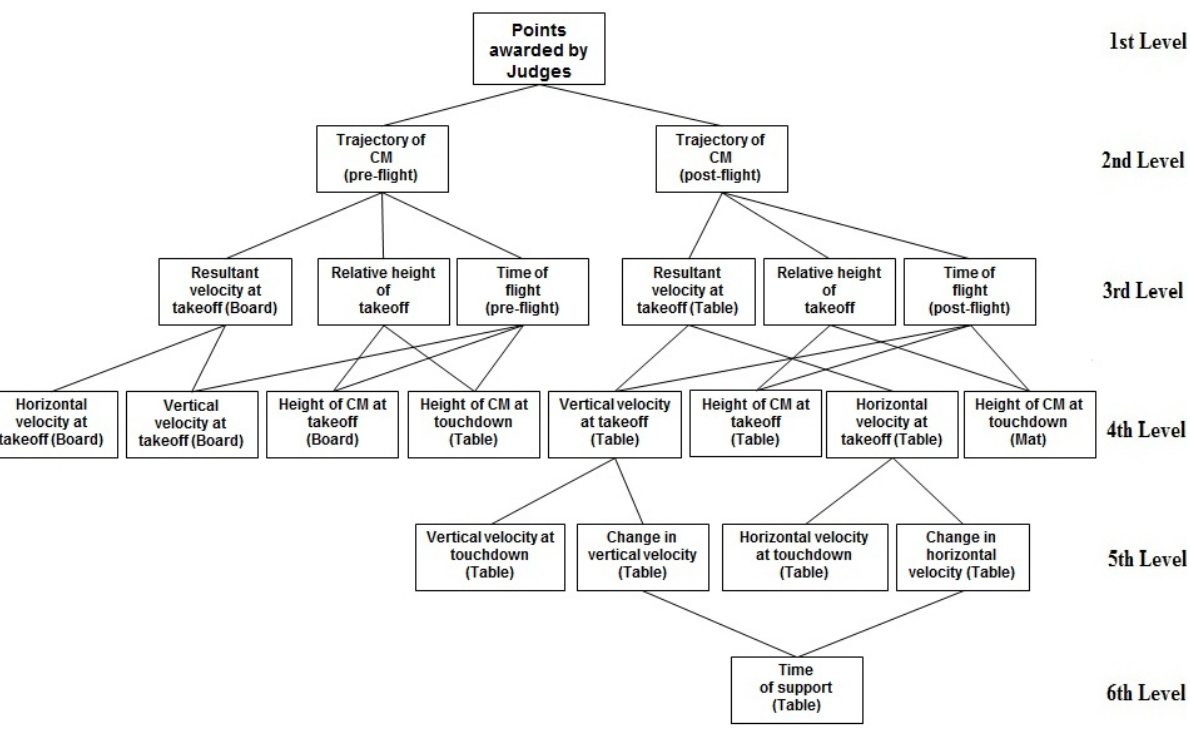
Figure 2. Model showing factors that determine the linear motions of the Tsukahara vault related to the judges’